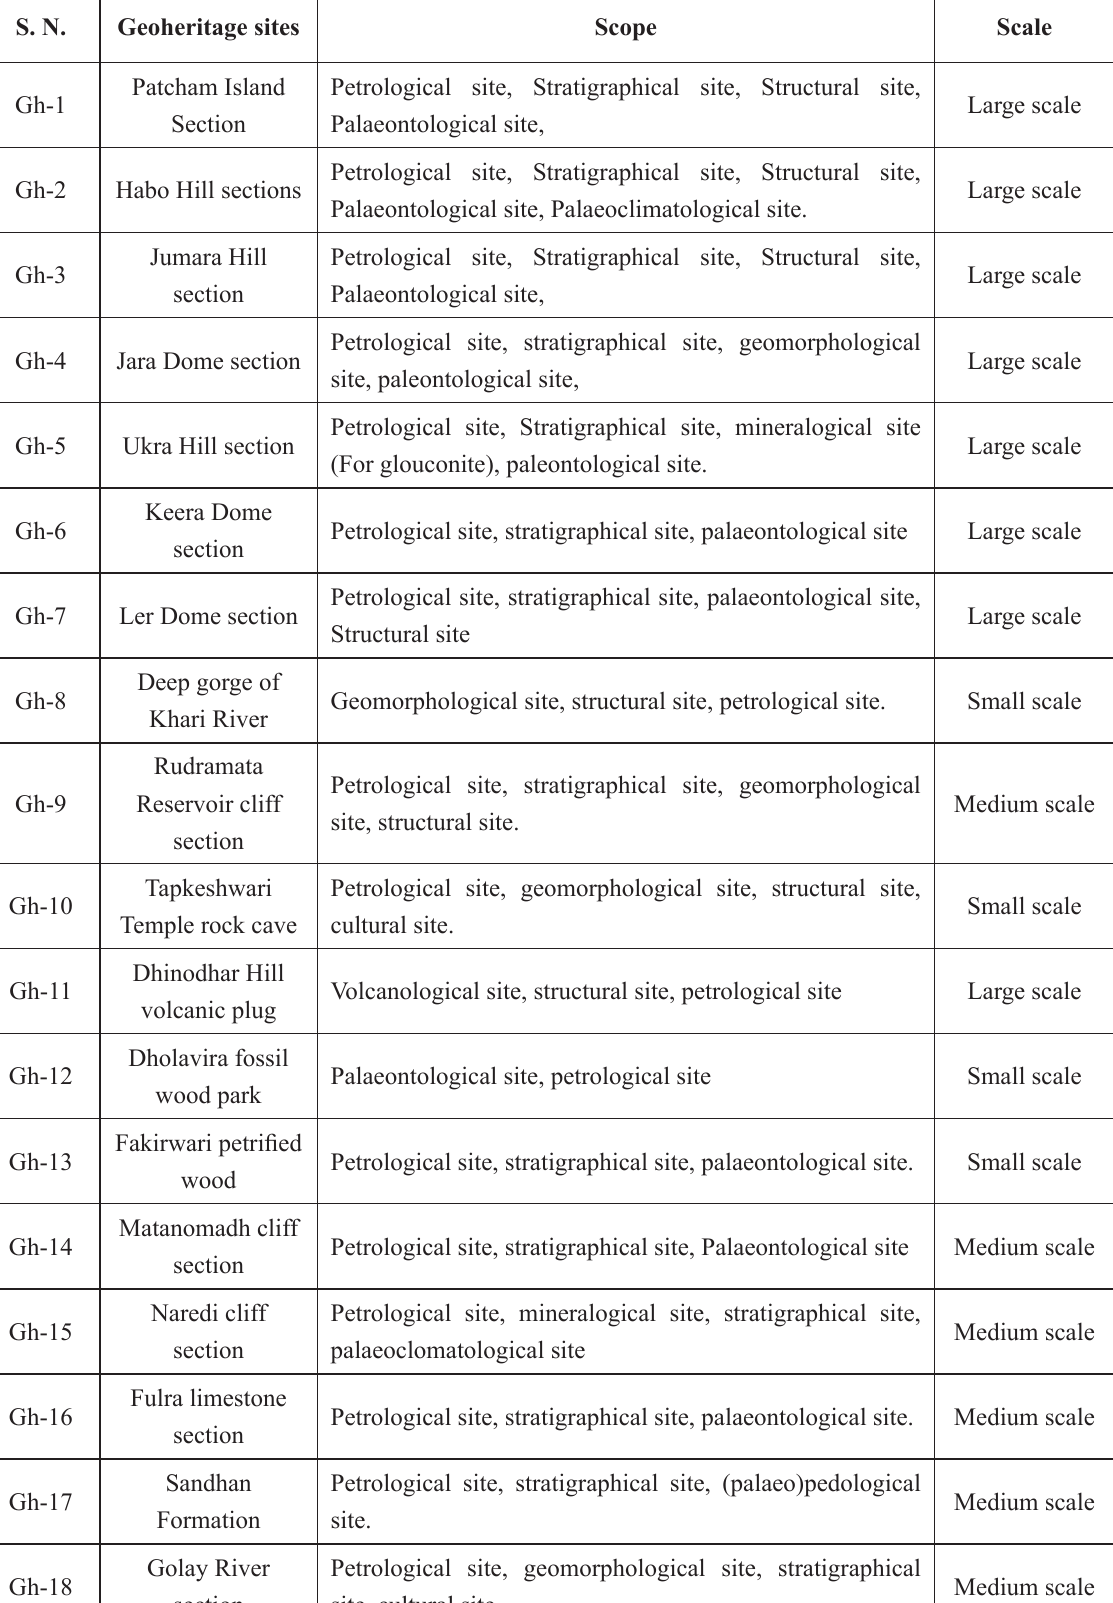
Table 1. Classification of the geoheritage sites of Kachchh, following the terminology of Brocx and Seminiuk (2007). S.